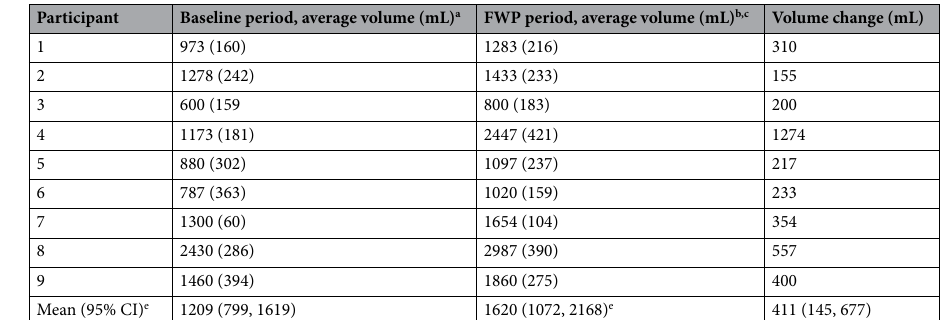
Table 3. Average fluid intake volume. a Mean (SD) for fluid intake over baseline days 1–3; includes all orally delivered thickened liquids and enteral delivered liquids. b Mean (SD) for fluid intake collected over FWP days 5–7; includes all orally delivered thickened liquids, thin liquid water, and enteral delivered liquids. c FWP free